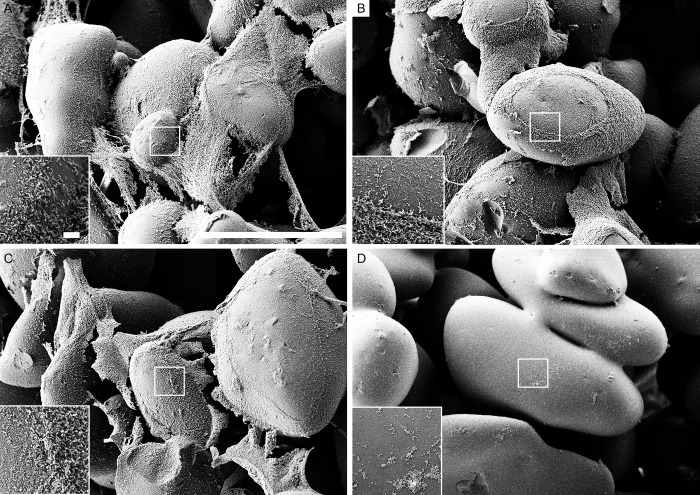
Scanning electron microscopy (SEM) of P. aeruginosa biofilm.(A) beads after 0.9% NaCl treatment (control). (B) beads after EDTA treatment. (C) beads after DTT treatment. (D) beads after sonication treatment. Scale bars: 200 μm (inserts in the images represent 5 μm).